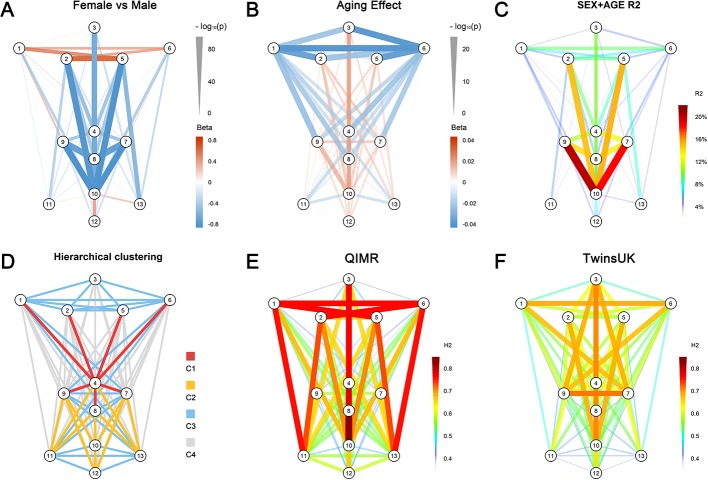
Phenotype characteristics of 78 facial traits.(A) Sex difference (RS, N = 3,193); (B) Aging effect (RS, N = 3,193); (C) Variance explained by sex and age (RS, N = 3,193); (D) Unsupervised hierarchical clustering of phenotype correlation matrix resulted in 4 clusters of phenotypes (RS, N = 3,193); (E) Twins heritability estimates in QIMR (N = 1,101) using 2D frontal photographs; (F) Twins heritability estimates in TwinsUK (N = 1,020) using 3D images.